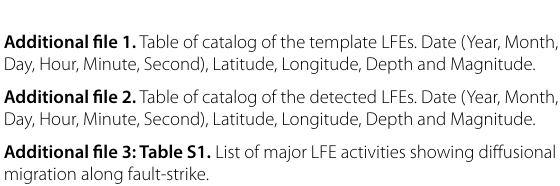
0 s corresponds to the text label =